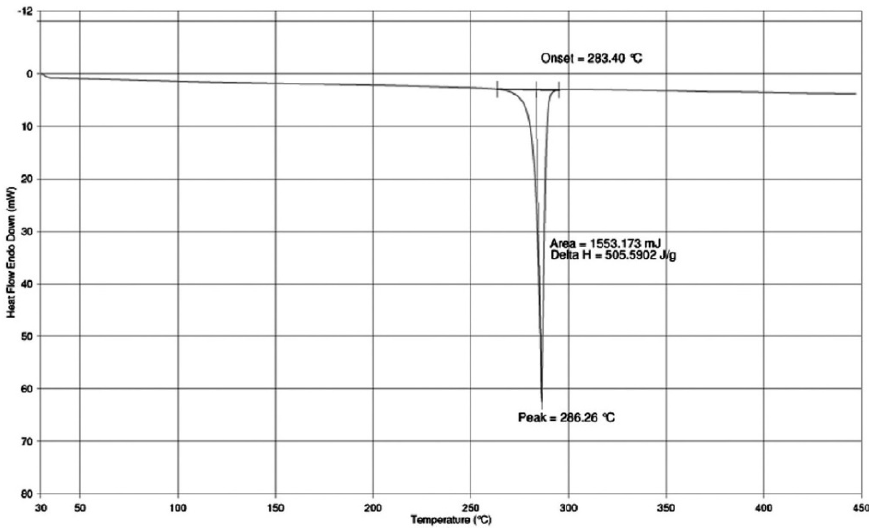
Fig. 4. DSC of mesalamine-chitosan nanoparticles